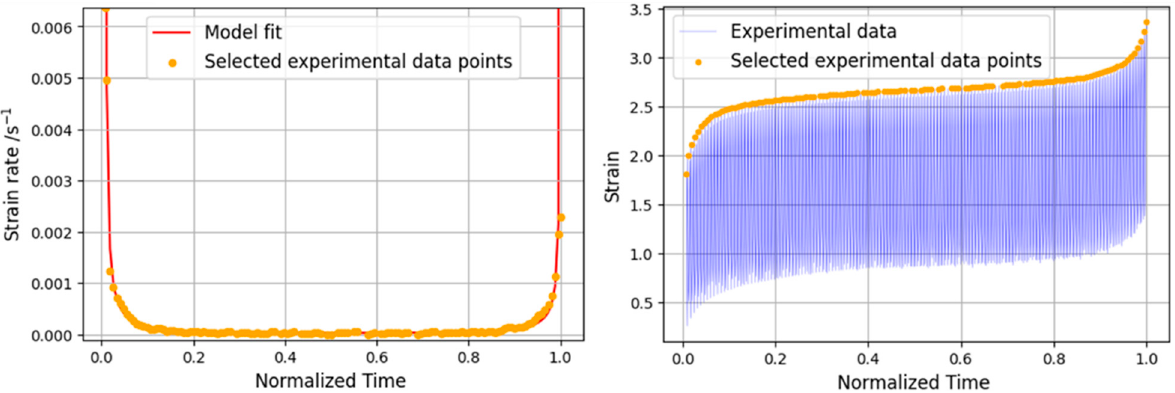
Figure 15. Strain rate calculated for cyclic creep test ( left ) and points extracted from the cyclic strain-time curve to use in the model ( right ).